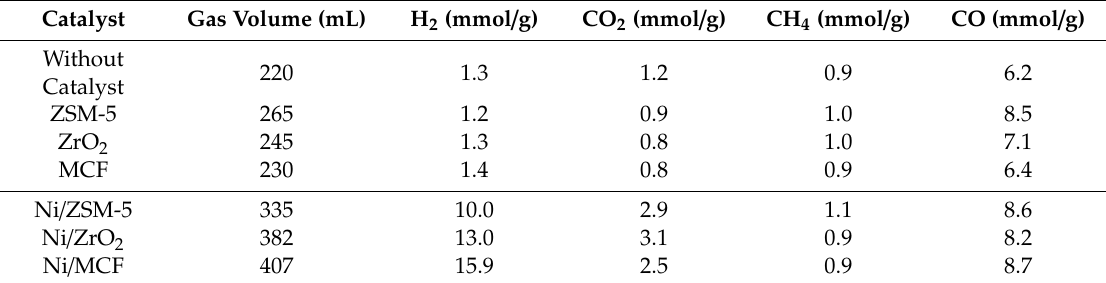
Table 1. Gaseous products formed in high-temperature conversion of cellulose.